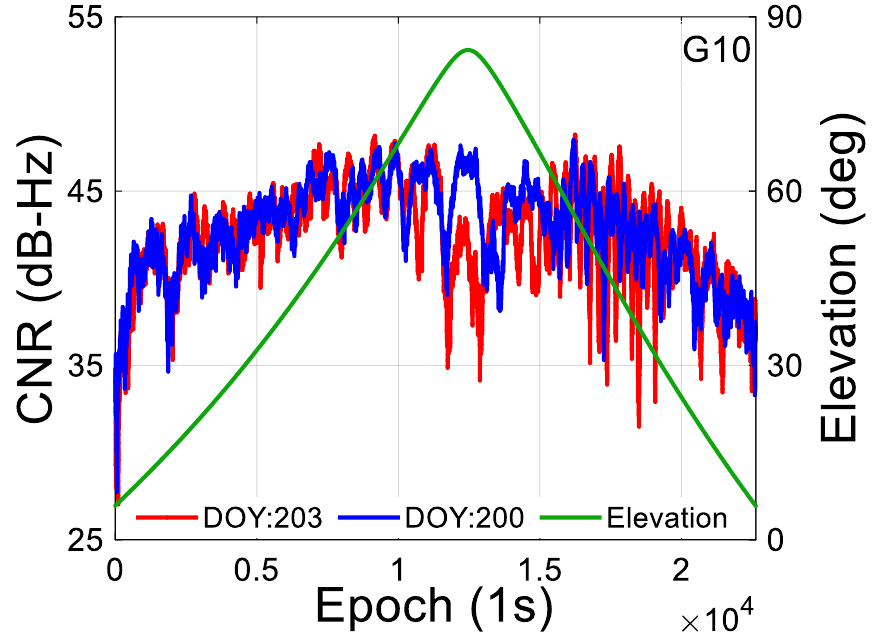
Figure 13. CNR of GPS G32 satellite L1 frequency comparison results with elevation as the horizontal axis. The blue dots denote the CNR collected on DOY:200 (no flood), and the red dots denote the CNR collected on DOY:203 (with flood). The green line is the elevation angle.